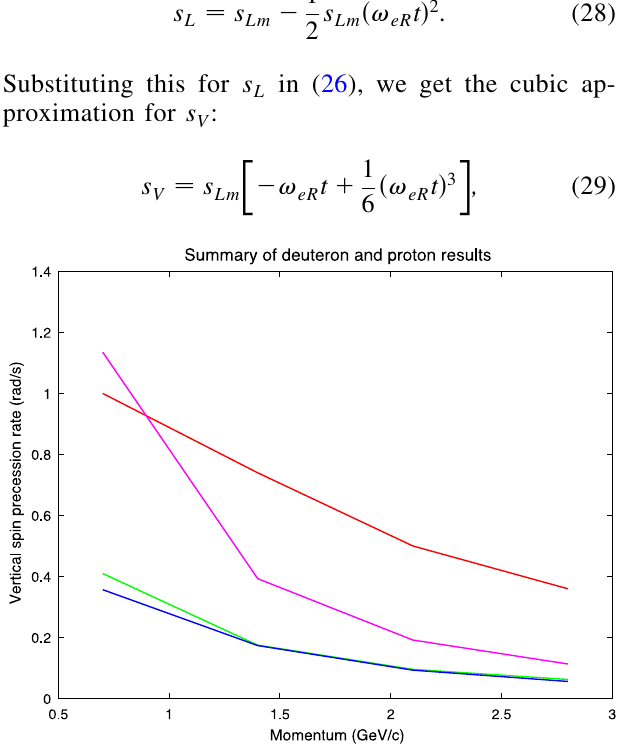
FIG. 5. The deuteron and proton results from tracking. The red corresponds to an EDM of 10 (cid:1) 18 e cm and green to systematic error due to a misalignment angle of 0.1 milliradian for the deuteron. The blue corresponds to an EDM of 10 (cid:1) 18 e cm and magenta to systematic error due to a misalignment angle of 0.1 milliradian for the proton.